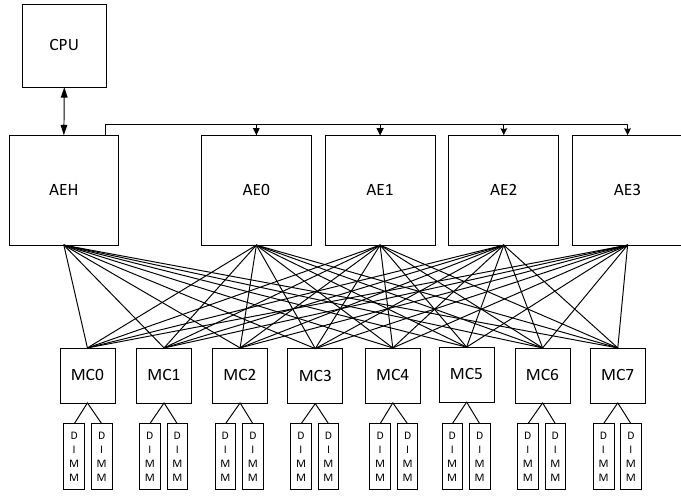
Figure 1. Convey HC-x architecture.